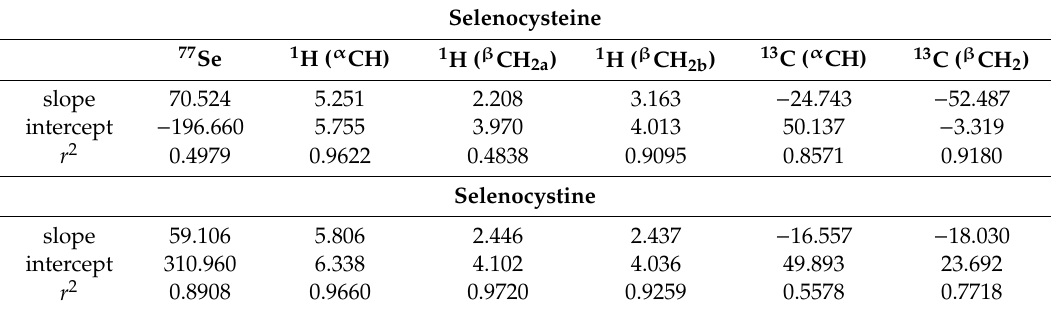
Table 5. Correlation data of selenocysteine standard redox potentials with the corresponding selenocysteine microspecies chemical shifts and the corresponding selenocystine microspecies chemical